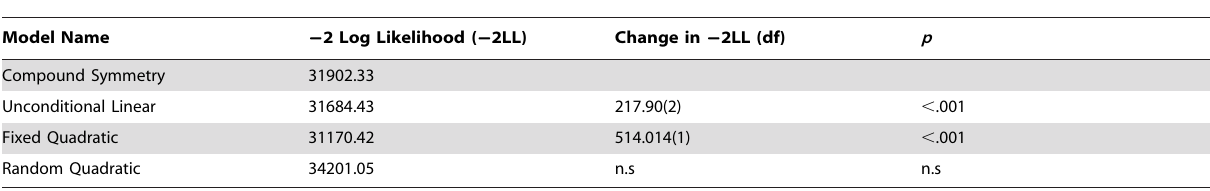
Table 3. Model Fit Summary Information.